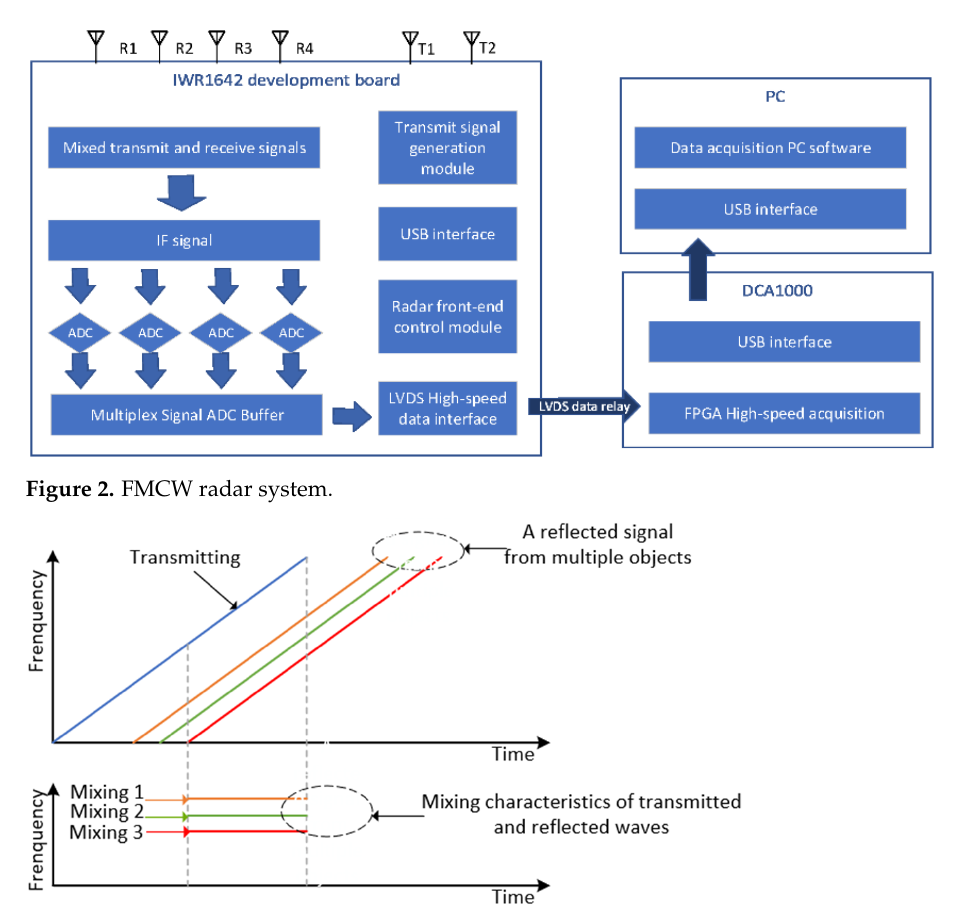
Figure 3. FMCW wave diagram.